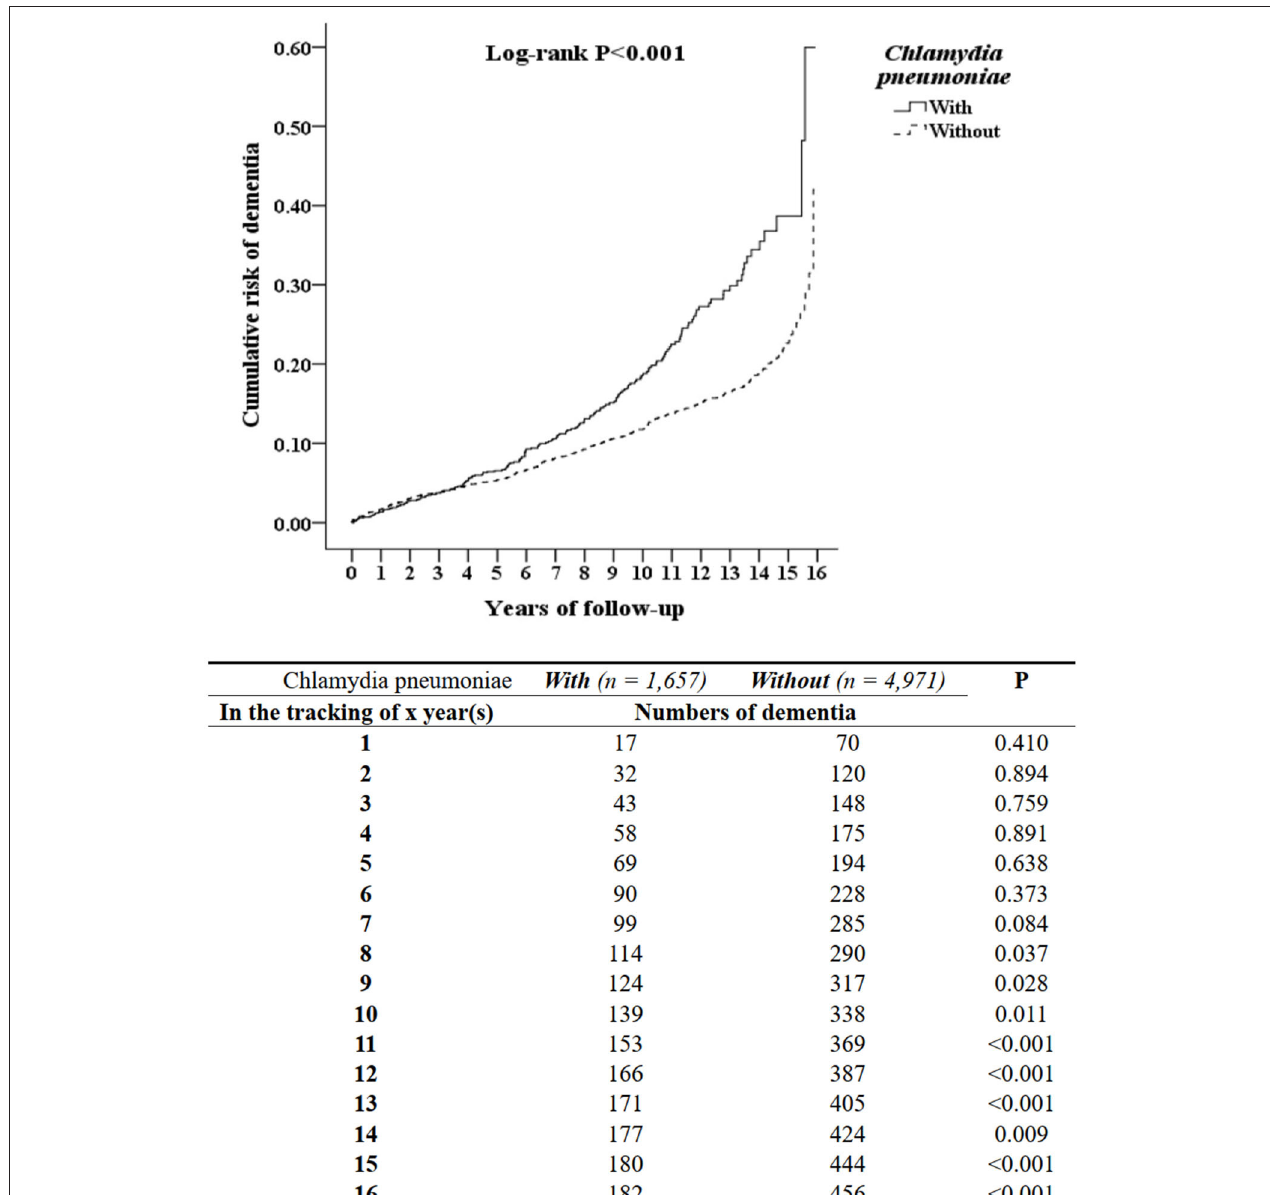
FIGURE 2 | Kaplan-Meier for cumulative risk of dementia aged 50 and over stratified by Chlamydia pneumoniae with log-rank